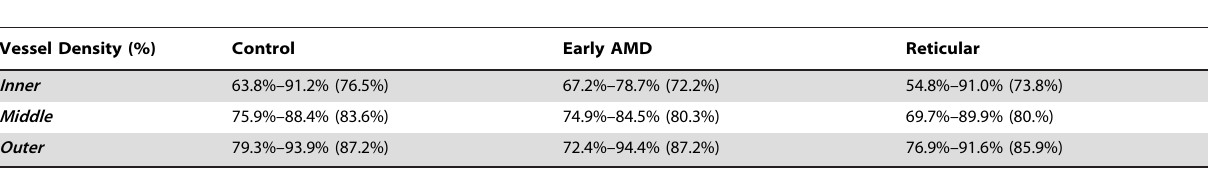
Full slices (6 6 6 mm) data; Control=epiretinal membranes; early AMD patients=drusen, reticular patients=reticular pseudodrusen with or without advanced atrophic or neovascular AMD, average densities in